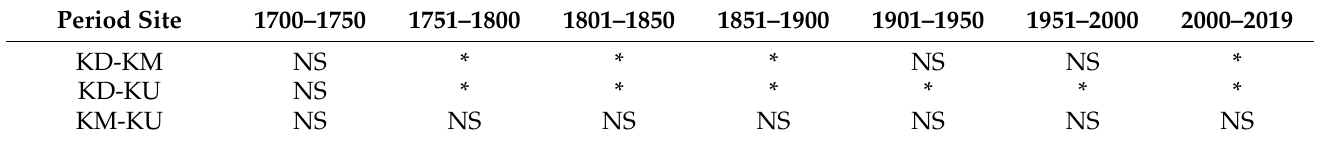
Table 1. Difference of synchrony in TRW, PCGA and Wilcox, * = sig > 0.05, NS = non sig.